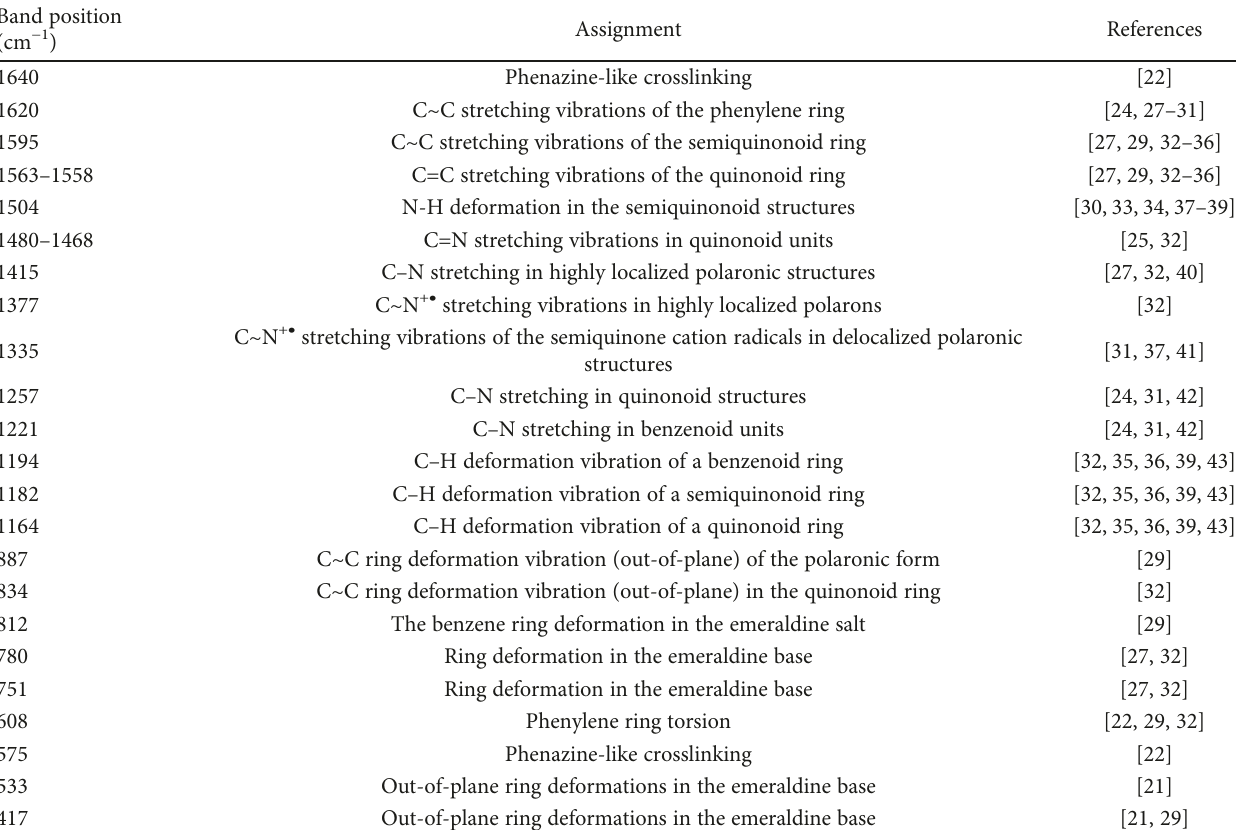
Table 1: Assignment of the Raman bands of